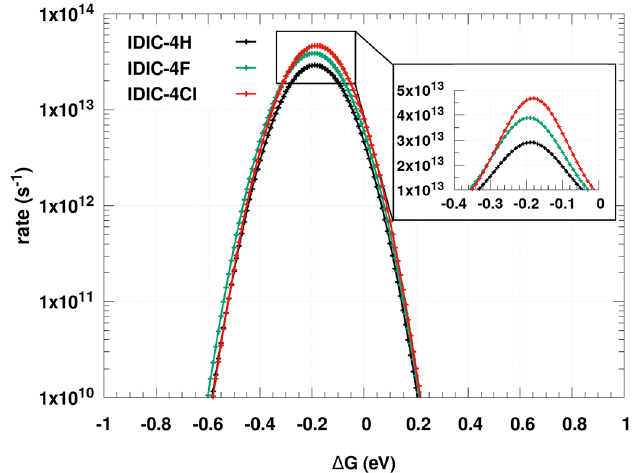
Fig. 8. Calculated Marcus rates as a function of site energy difference for the three